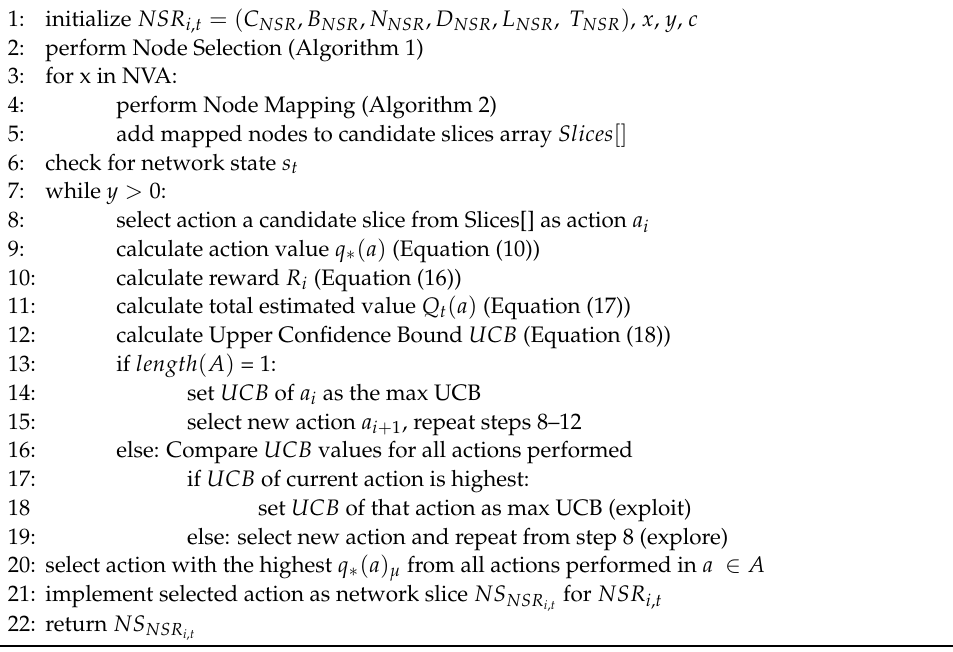
Algorithm 3. Proposed Deep Contextual Bandit Network Slicing